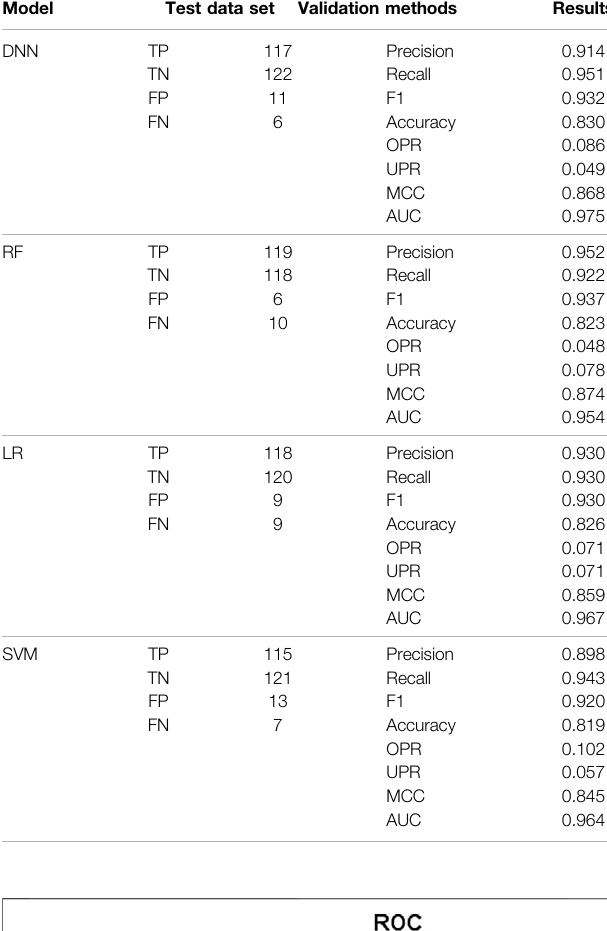
TABLE 5 | Model validation results using multiple methods.